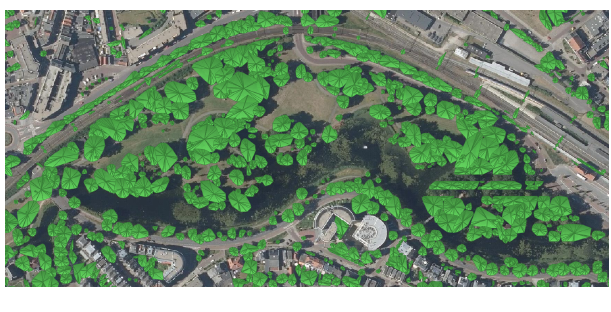
Figure 11. Park tree map 2D